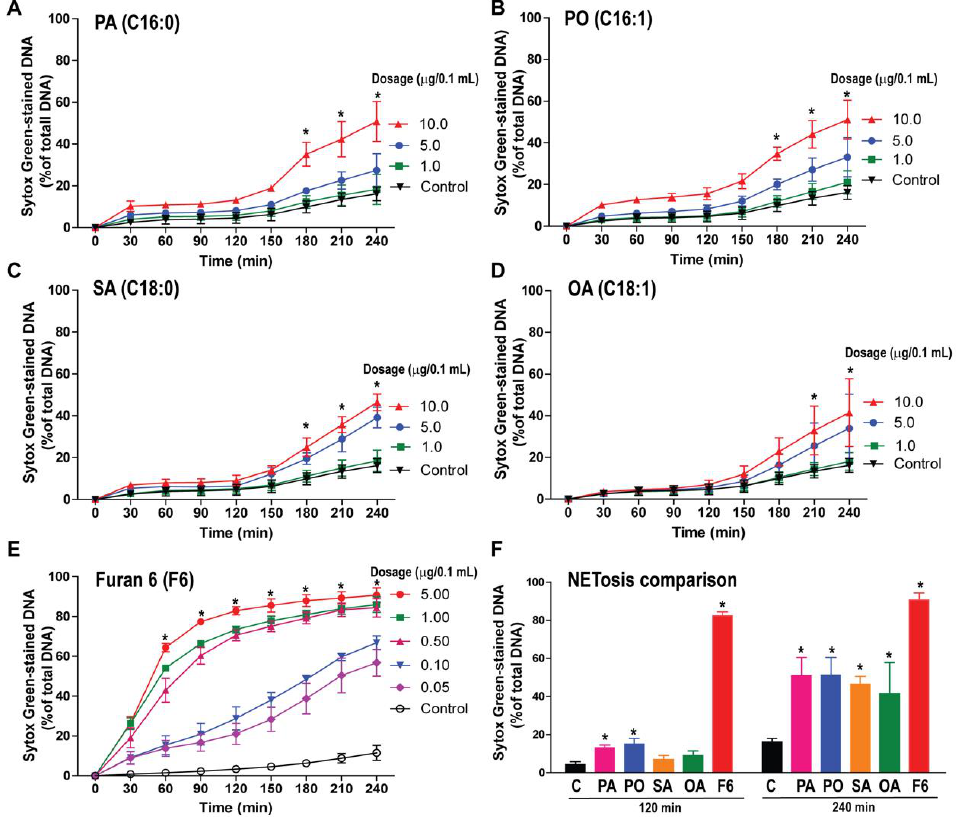
Figure 2. Furanoid acid (F-acid) F6 contributes to most of the rapid NETosis effect exerted by lipid fraction-3 (Ft-3). The SytoxGreen NETosis kinetics analysis was performed in the neutrophils treated either with −ve control (ethanol), or with different concentrations of palmitic acid (PA; 16:0), palmitoleic acid (PO; 16:1), stearic acid (SA; 18:0), oleic acid (OA; 18:1), or furanoid acid (F6). ( A – D ) The % DNA release data show slow kinetics and a lower % DNA release in neutrophils activated with PA, PO, SA, or OA. By contrast, F6-treated neutrophils ( E ) showed rapid kinetics and a greater % DNA release ( n = 3, * p -value < 0.05 compared with the control; two-way ANOVA with Bonferroni’s multiple comparison post -test); ( F ) The comparative analyses of the % DNA release between F6 and other fatty acids showed up to 65% more NET release by F6 at 120 and 240 min ( n = 3, * p -value < 0.05; One-way ANOVA with Dunnett’s post-test, compared to